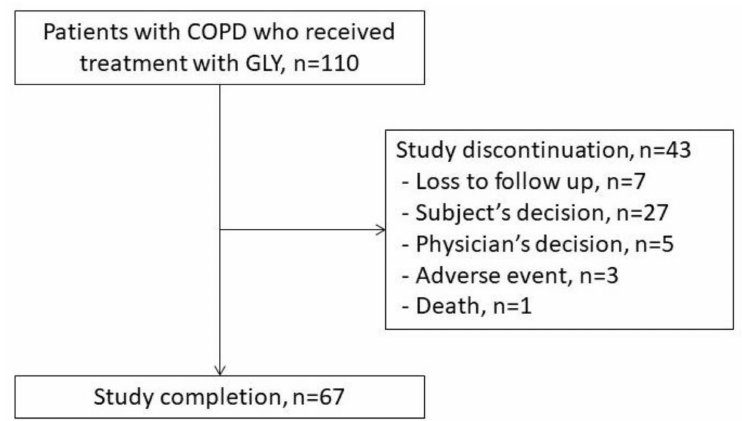
Figure 1. The patient enrolment flow chart. Abbreviations: COPD, chronic obstructive pulmonary disease; GLY, glycopyrronium.